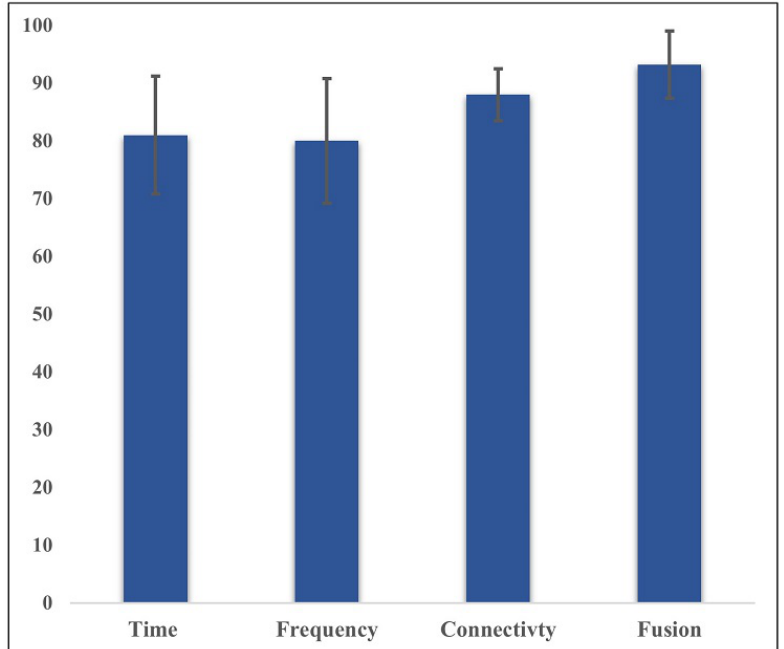
Figure 12. A summary comparison between the average accuracy of single subset domain fea- tures (time domain, frequency domain, connectivity network features) and the fusion of all three using